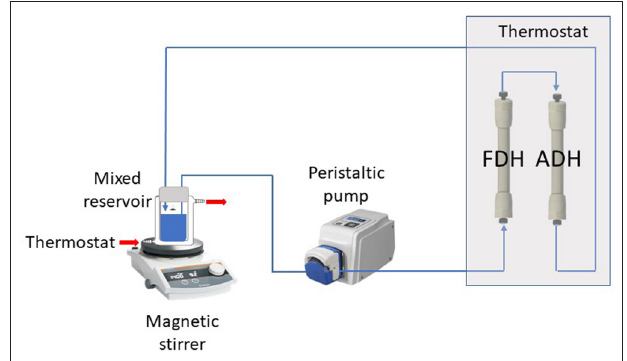
FIGURE 1 | Experimental two-enzyme system with infinite